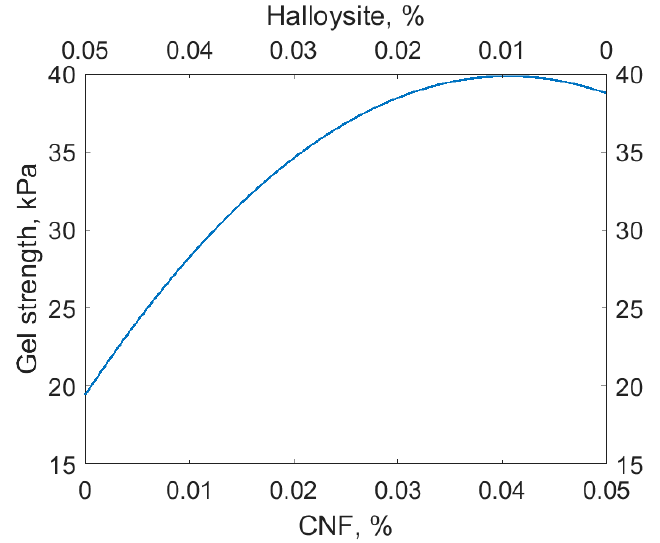
Polymers 2019 , 11 , x FOR PEER REVIEW Figure A3. Modeled gel strength at 240 h for the total added amount of CNF and halloysite of 0.05 mass%.